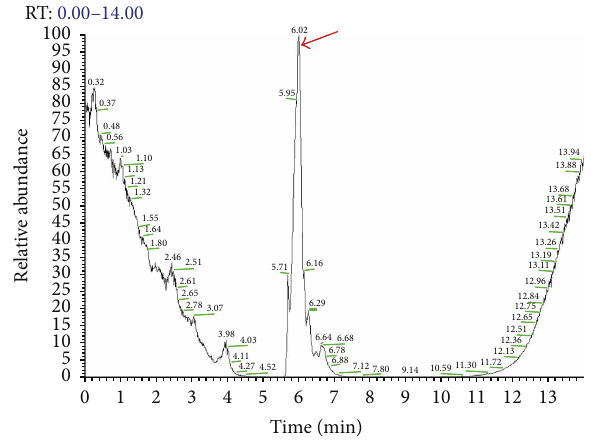
Figure 8: Mass spectrum peak with retention time of 3.96 min; the molecular weight by deconvolution was estimated to be 8249.94 Da.